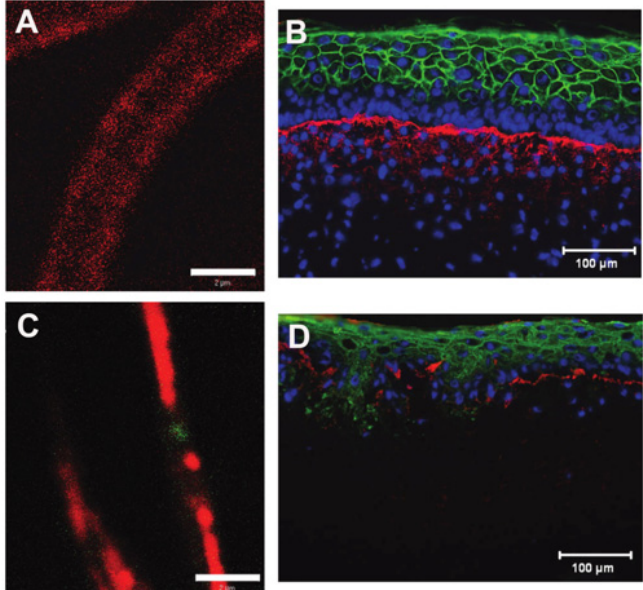
Figure 5. Confocal images of pure collagen (red) ( A ) and collagen (red)-polycaprolactone (PCL) (green) blend electrospun fibers ( C ) showing the segregation of the collagen and PCL components at a total PCL concentration of 30% total polymer mass. Scale bar = 7 µm. These large gelatin and PCL domains within the fiber reduced the ability of the collagen-PCL blend to support the formation of a well-stratified engineered skin ( D ) (blue = DAPI, red= collagen IV, green = involucrin) despite improvements to acellular scaffold strength and resistance to degradation. Pure collagen scaffolds support the development of bilayered engineered skin with a stratified epidermis ( B ). Modified from [75] with permission.